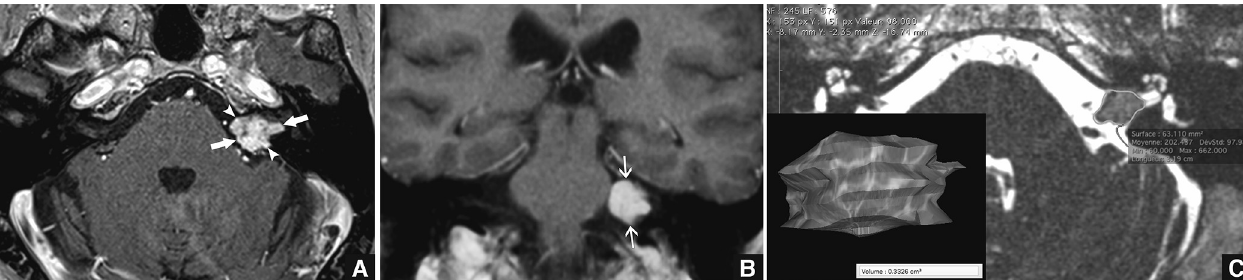
Fig 1. MRI measurements. A and B) The largest anteroposterior diameter (arrowhead) and mediolateral diameter (large arrows) were measured on axial section (A). The largest superoinferior diameter (thin arrows) was measured on coronal section. Anteroposterior and superoinferior diameters concerned cerebellopontine angle (CPA) extent only. Mediolateral diameter included both CPA and internal auditory meatus (IAM) extent. C) Volumetric measurements were performed as shown by contouring the tumor in every axial section on HRT2-weighted images. Volume was then calculated automatically using OsiriX